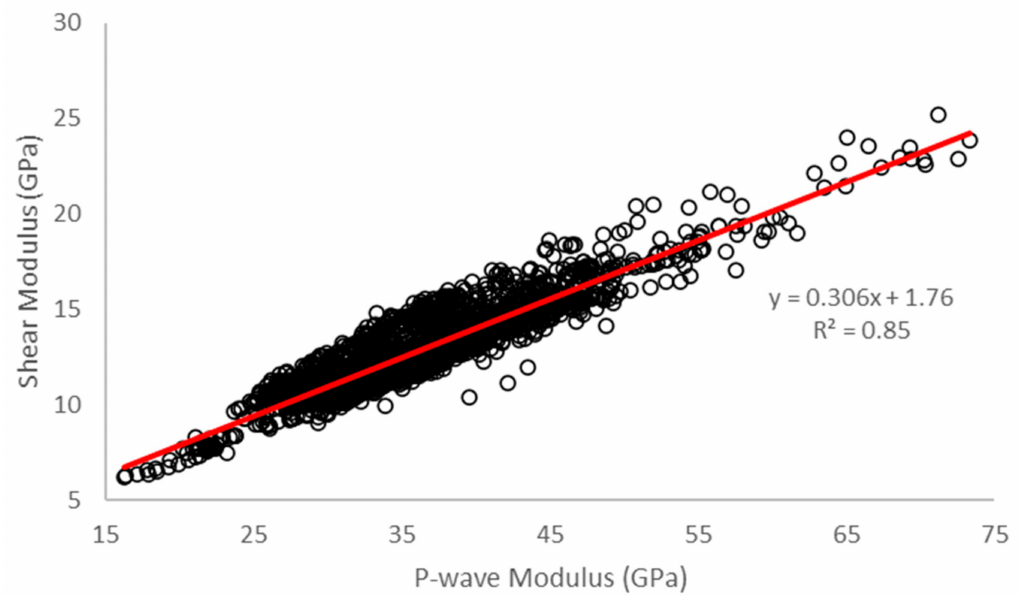
Figure 6. Dynamic shear modulus versus dynamic P-wave modulus for all formations combined from sonic and density log measurements. The least-mean-square error trendline is µ = 0.306 M + 1.76 for units in GPa. The correlation coe ffi cient is 0.92 and the std error of the prediction is 0.92 GPa. The F-statistic is over 11,000 and sig F is 0. This trend provides a useful estimation of dynamic shear modulus given only V p and ρ but can be refined with correction for composition (see